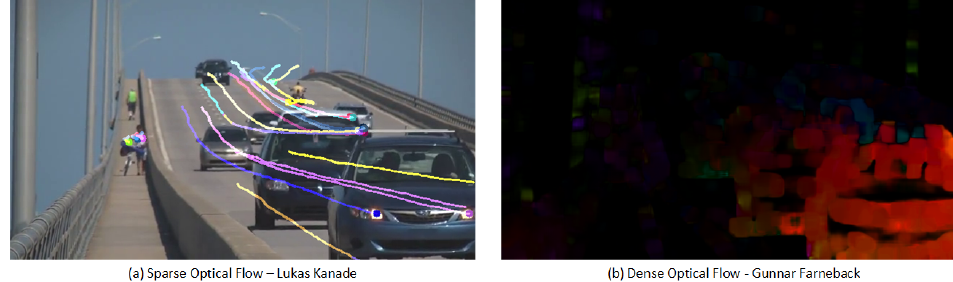
Figure 2. Sparse Optical Flow vs. Dense Optical Flow. ( a ) Sparse Optical Flow-Lukas Kanade; ( b ) Dense Optical Flow-Gunnar